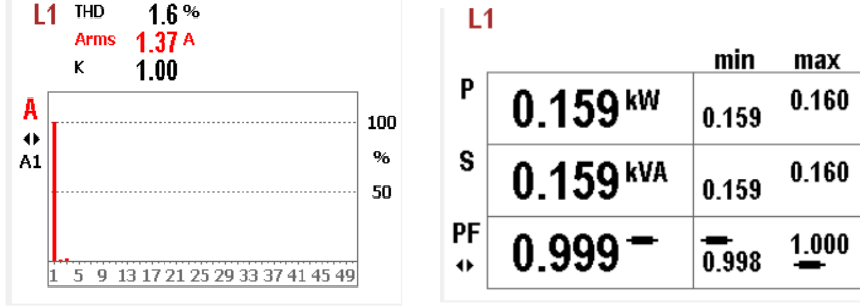
Figure 19. Measured THD and harmonic spectra, and PF when the ESS is discharged.